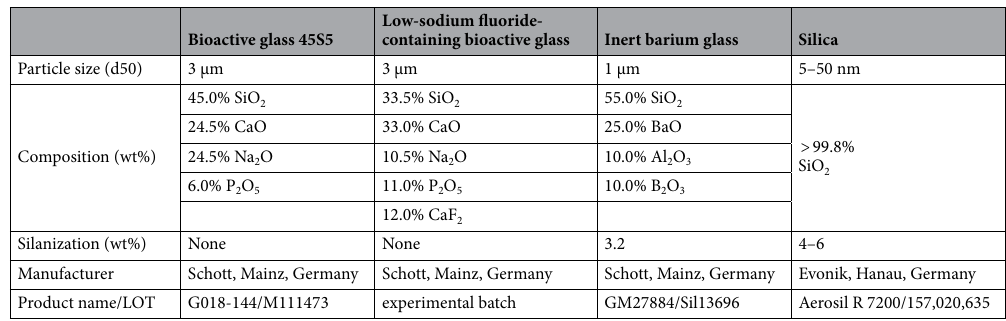
Table 1. Fillers used in preparation of experimental resin